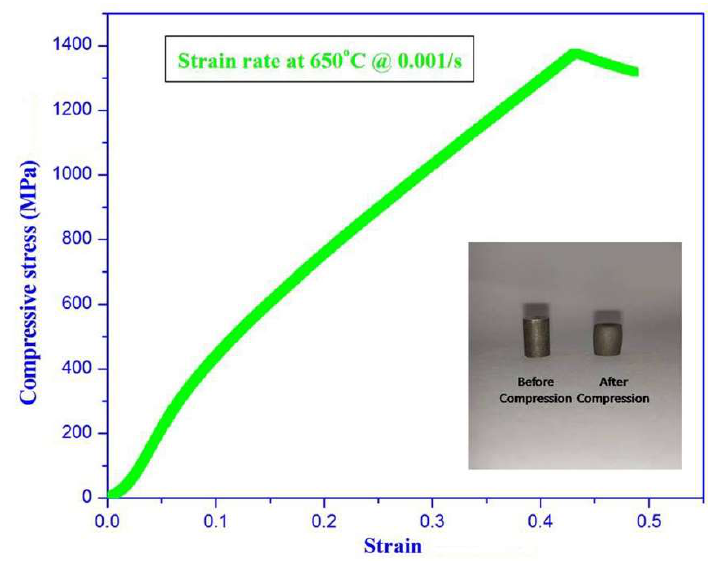
Figure 10. Hot compressive strength of the sintered sample, sample before and after compression (insert).